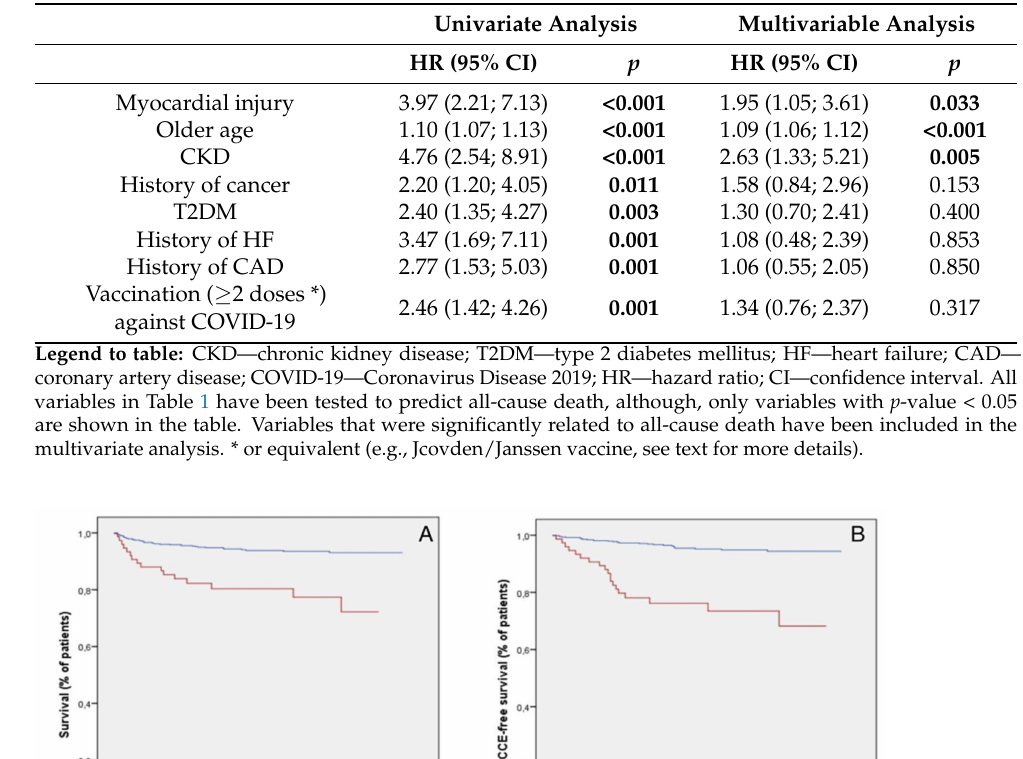
Table 3. Predictors of all-cause death in the overall population by univariate and multivariate Cox regression analysis.